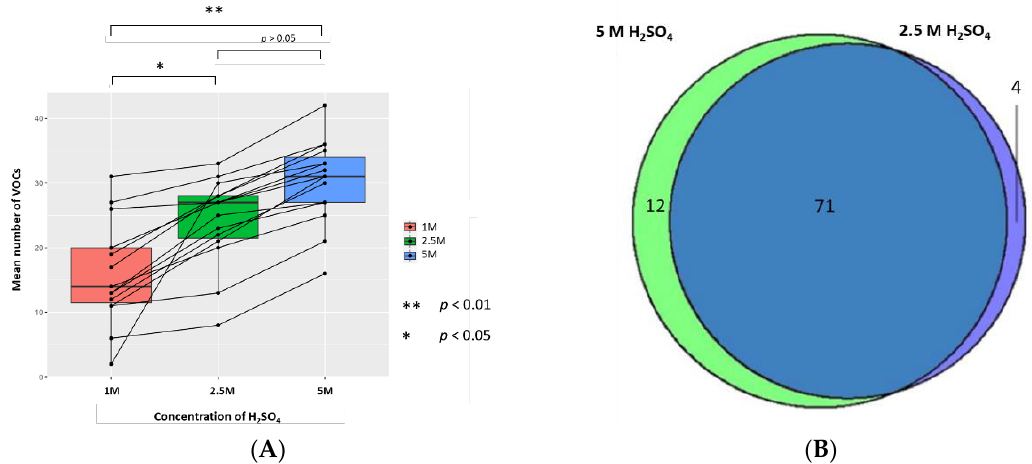
Figure 3. The urinary VOC profiles using 1 M (red), 2.5 M (green), and 5 M of H 2 SO 4 (blue) as the treatment technique (to generate sample solutions of 0.17 M, 0.42 M, 0.83 M, pH 0.743, pH 0.365, and pH 0.075 respectively) ( n = 15). ( A ) Paired boxplot to show the cumulative number of unique VOCs produced per sample for each concentration of H 2 SO 4 . ( B ) Venn diagram showing the unique VOCs detected between 5 M and 2.5 M H 2 SO 4 .